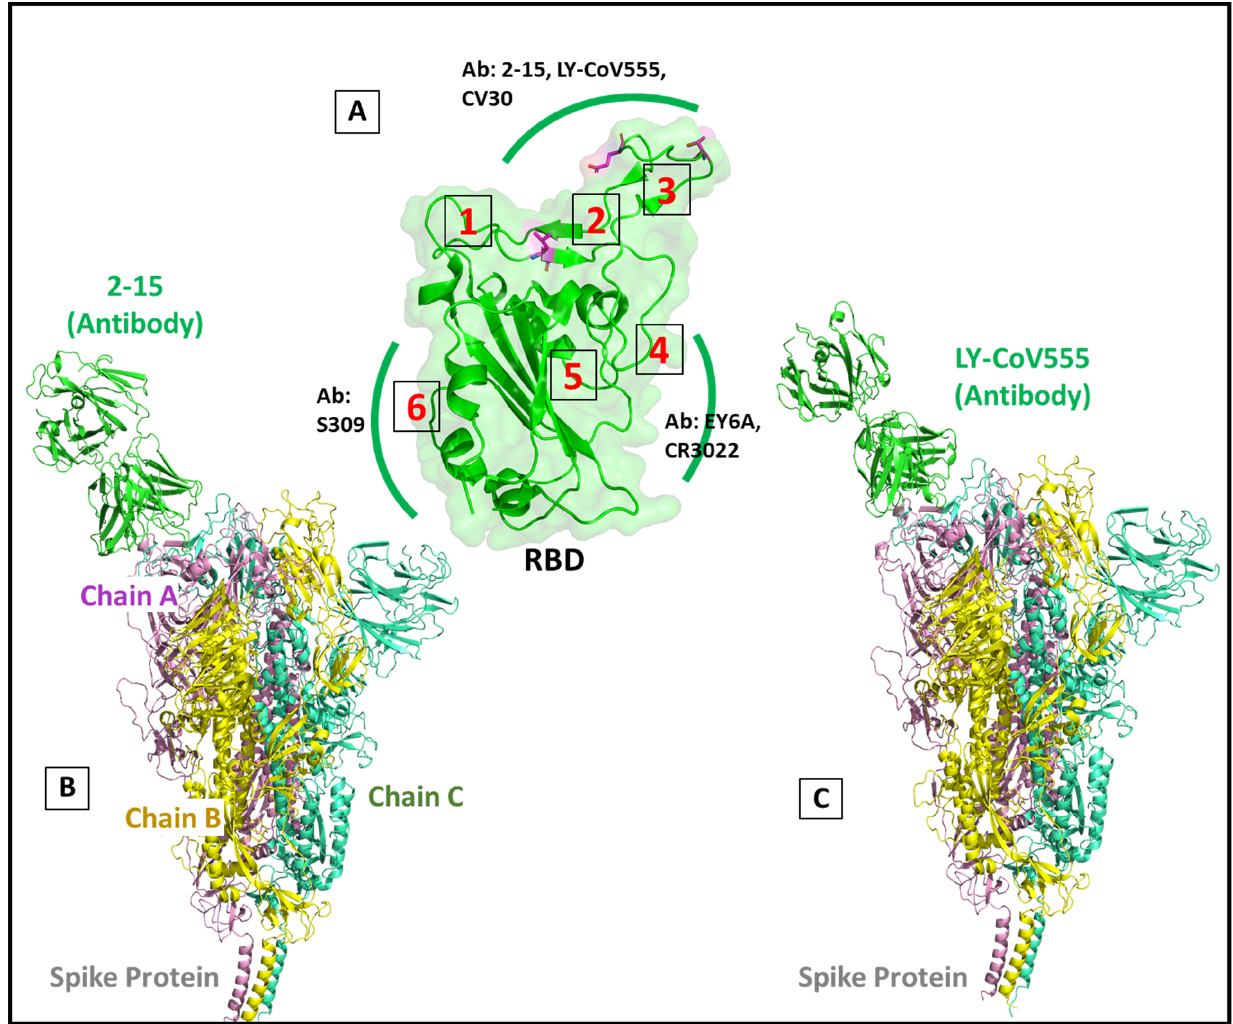
Figure 11. Diagrammatic representation depicting different antibody binding regions on the RBD. ( A ) ribbon and surface representation of RBD showing different antibodies targeting different regions. The mutant residues are colored in magenta ( B , C ) ribbon representation showing antibody 2-15 and LY-CoV555 orientated to RBD. Table 2. The interaction-free energies between the RBD (wtRBD, kRBD and dRBD) in complex with the ACE2 (in kcal/mol) for neutralizing antibodies 2-15 and LY-CoV555. DELTA G (Avg./Std.